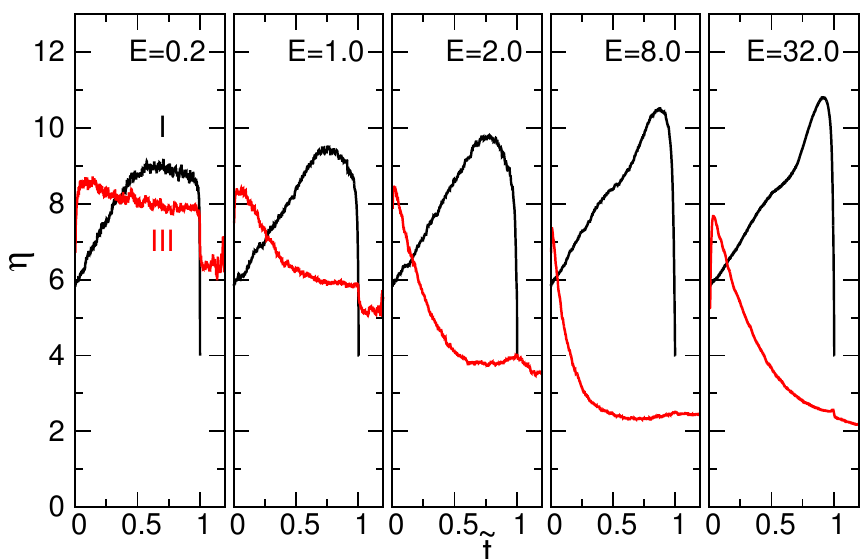
Figure 2. Shape factor η = (cid:104) R 2 e (cid:105) / (cid:104) R 2 g (cid:105) in the cis region (I) and trans region (III) for N = 256 as a function of the scaled time ˜ t at five driving electric fields E whose values are indicated in the